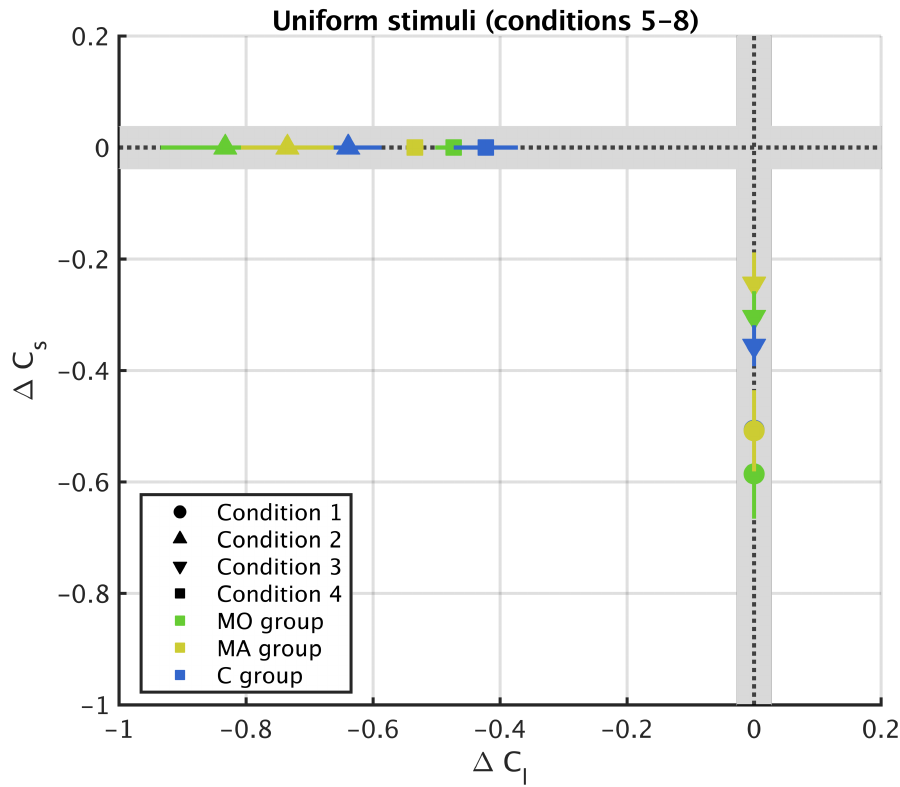
Figure 6. Experimental results for uniform surrounds (Conditions 5–8 of Table 1) in metric units (see Equation (1)) along the two chromatic axes l and s . The larger the | ∆ C | , the stronger the chromatic induction. Positive values show that colour assimilation is occurring and negative ones show that colour contrast is occurring. Grey region indicates the JND region. Symbols indicate the mean value for the different groups and error bars indicate the standard error of the